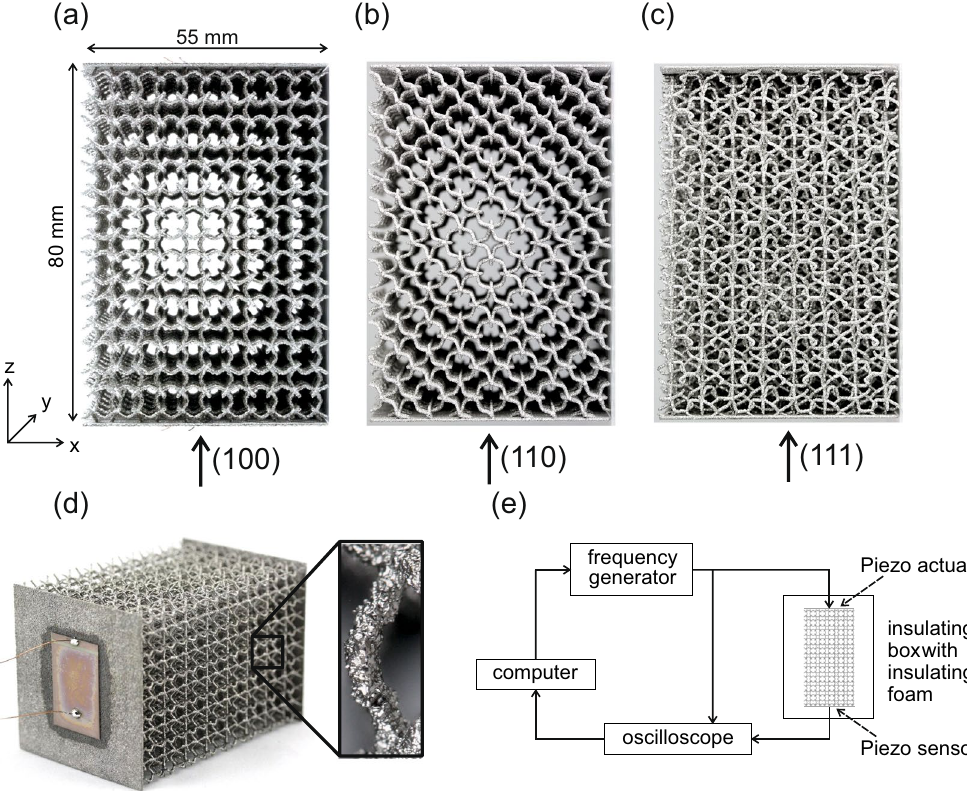
Figure 2. Pictures of SEBM samples made from Ti-6Al-4V powder and consisting of 8 unit cells in z-direction bordered with thin walls at each end and experimental setup. ( a ) Side view of a sample with transmission direction (100), ( b ) (110) and ( c ) (111). ( d ) Scenographic view of a (100) sample and close-up view of a strut. Piezoelectric elements are glued onto the walls. ( e ) Schematic of the experimental